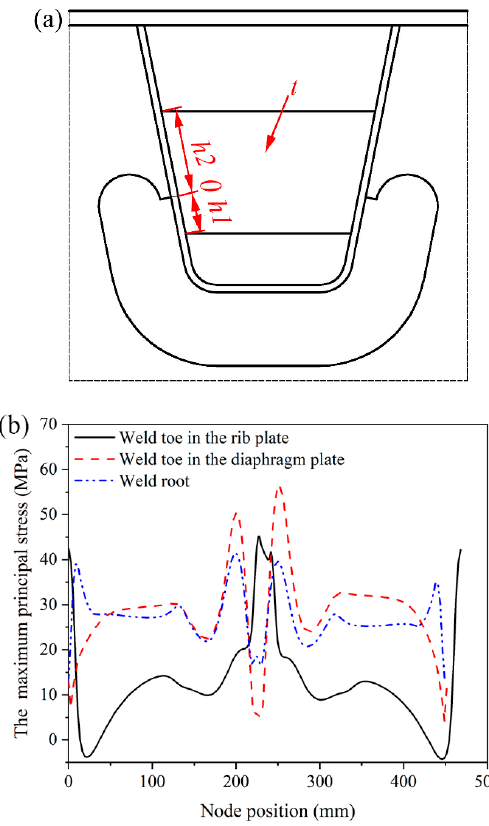
Figure 13. ( a ) Reinforcing plates in improvement scheme 1 and ( b ) stress–node position curves of the rounded welding region.